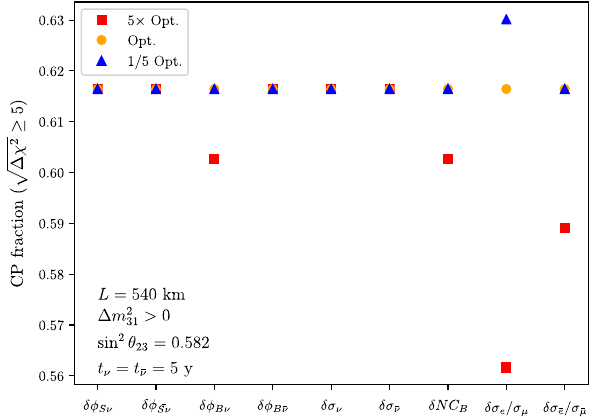
Fig. 10 Impact of different sources of systematic errors on the frac- tion of values of δ for which a (cid:7)χ 2 > 25 exclusion of CP conservation would be possible at the Garpenberg mine. The orange circles corre- spondtotheCPfractionwiththe“Optimistic”systematicsfromTable1, red squares correspond to assuming that particular uncertainty to be 5 times larger and blue triangles to reducing the uncertainty by a factor of